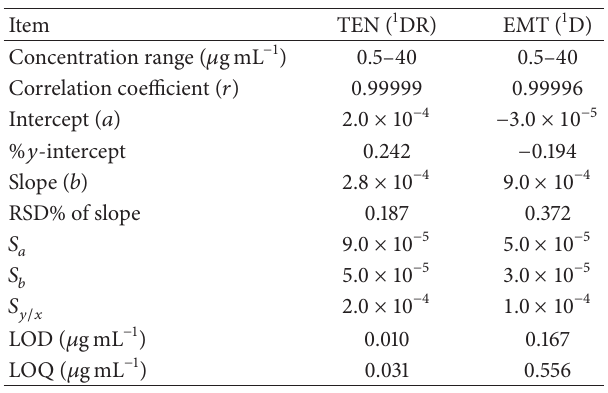
Table 1: Validation data for the determination of TEN and EMT using the proposed spectrophotometric methods.